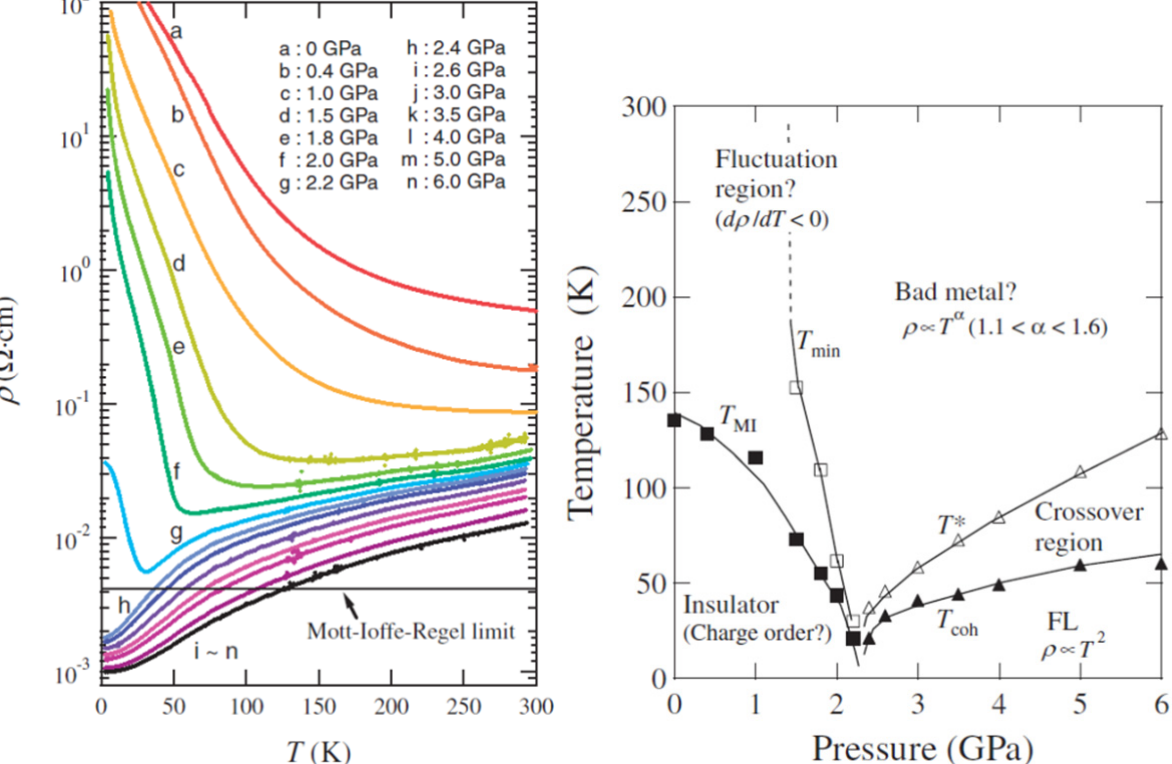
Figure 9. Temperature dependence of resistivity of κ -(MeDH-TTP) pressure by cubic anvil cell with pressure medium of Daphne 7373 (top